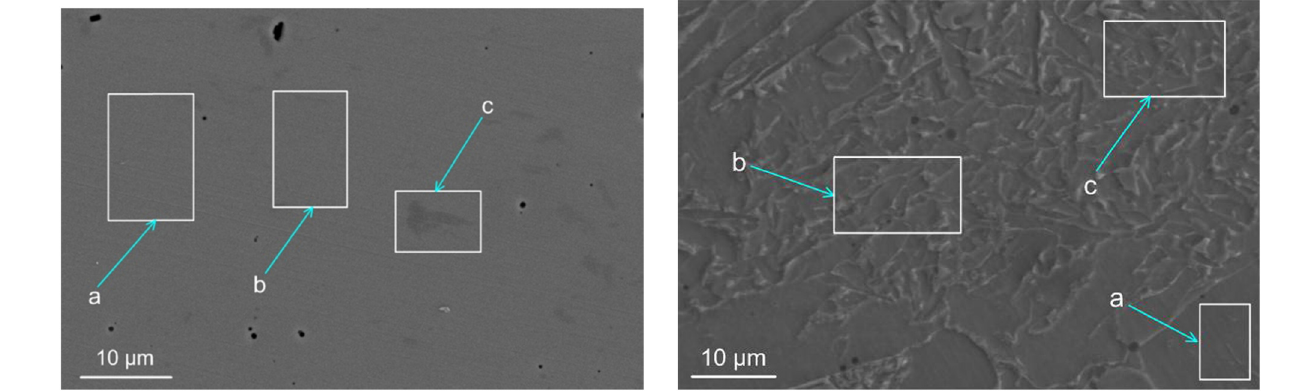
Figure 4: SEM micrograph of BC weld metal with analyzed areas a, b and c (× 4,500 )